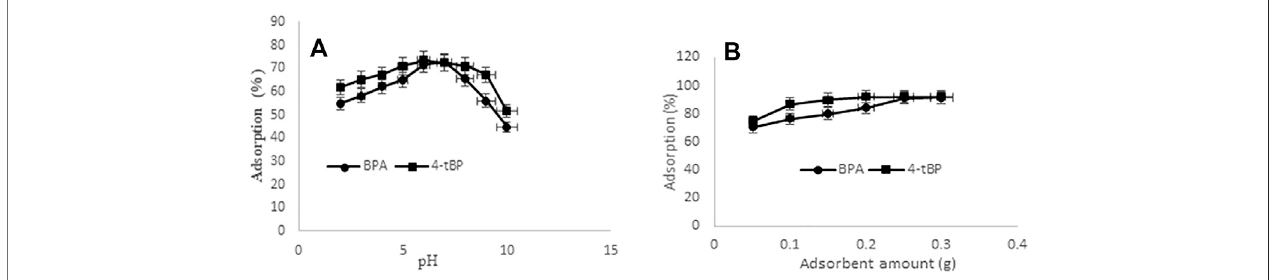
FIGURE5|(A) Effect ofpH and (B) effect ofMC dose onthe adsorption ofBPAand 4- tert -BPonto MC. Conditions: (A) adsorbent 0.1 g,pH 3 – 10,time 60 min at roomtemperature,concentrationofanalyte25 µgml − 1 and (B) pH7,adsorbent0.05g – 0.3 g,time60 minatroomtemperature,andconcentrationofanalyte 25µgml − 1